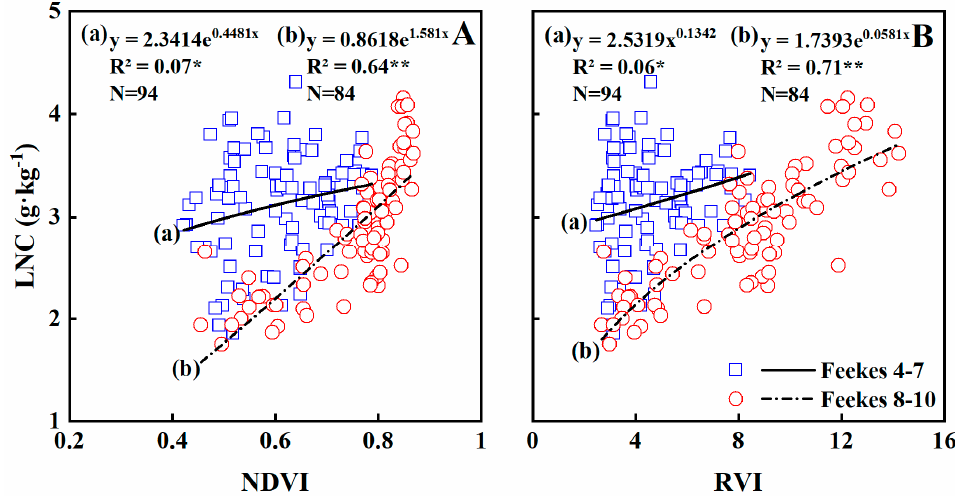
Figure 6. Quantitative relationships of NDVI ( A ) and RVI ( B ) to LNC in wheat varieties under varied N rates across all growth stages.